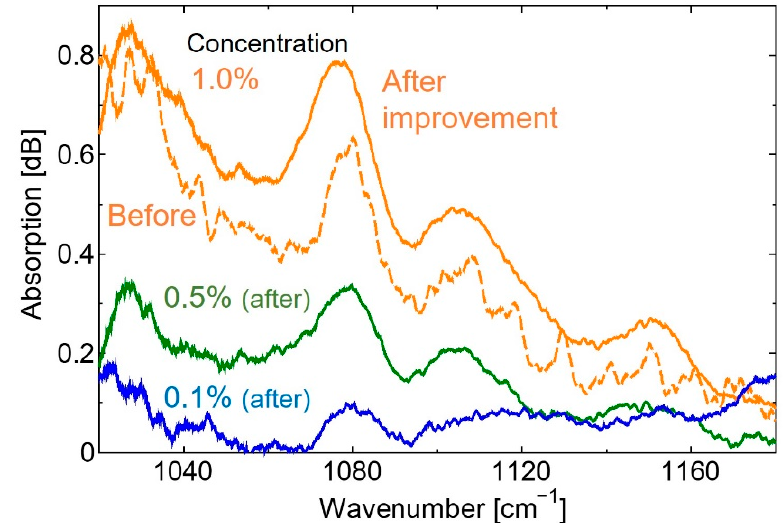
Figure 8. The absorption spectra of the glucose solution provided by the improved system.